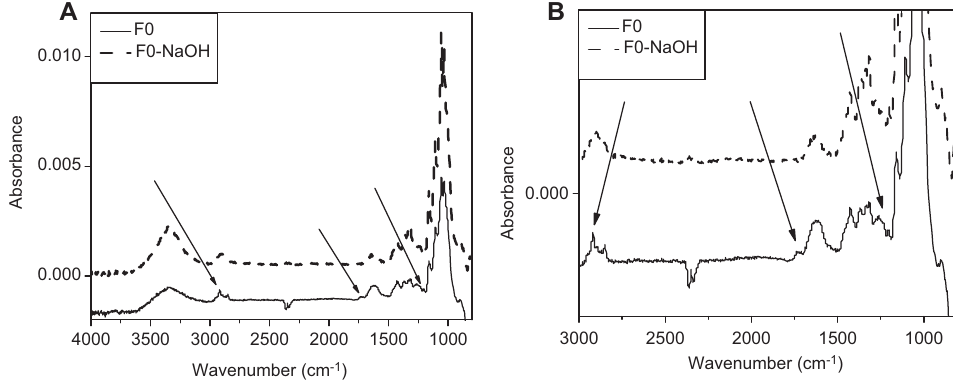
Figure 2 FTIR spectra of F0 and F0-NaOH, (B) is the enlarged spectra of part of